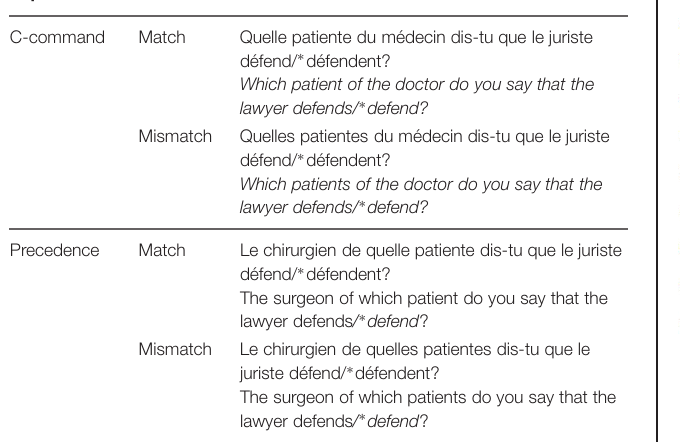
TABLE 3 | Example of an item in the eight experimental conditions of Experiment 3.